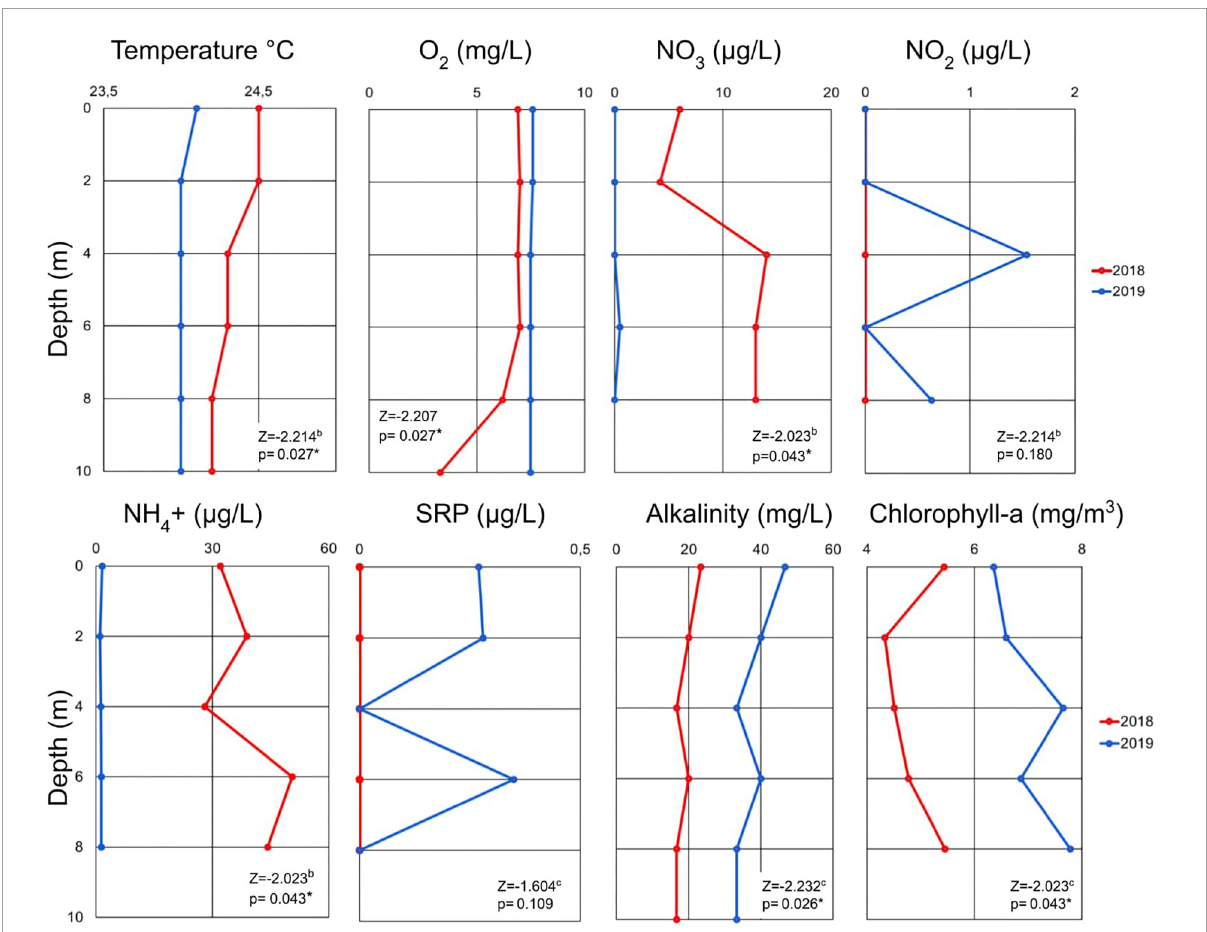
FIGURE1 Vertical profile of physicochemical variables in Cote Lake for the two sampling dates in 2018 and 2019 according to depth. Wilcoxon sum rank test values for the comparison between 2018 and 2019 variables are showed in the table. The asterisk shows significant differences ( p < 0.05) (SRP: Soluble Reactive Phosphorus; The 10 m depth data collected in 2018 excluded due to possible contamination because the alpha bottle touched the